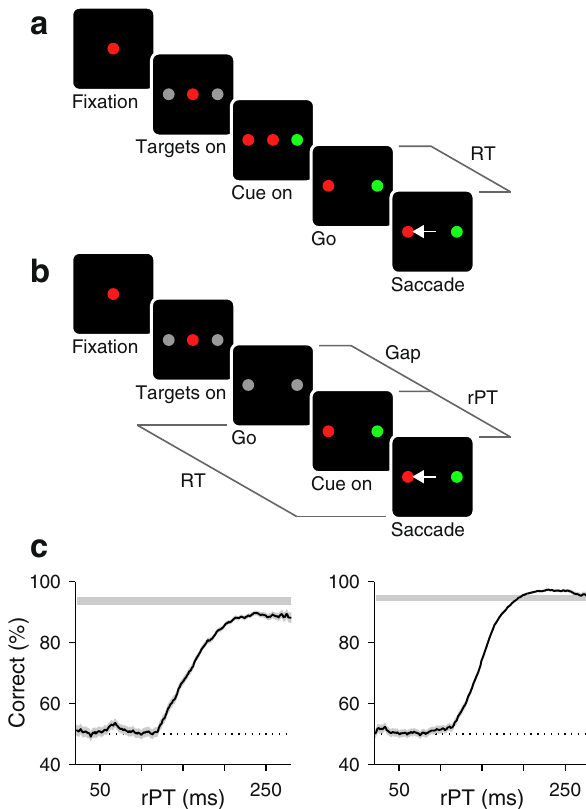
Fig. 5 | Urgent and non-urgent color-discrimination tasks. Subjects had to look to the peripheral target that matched the color of the fi xation point. a Easy, non- urgenttask.Thecolorstimuliare presented fi rst(Cue on),and after500 – 1000ms, thegosignal( fi xationpointoffset;Go)isgiven. b Urgenttask.Thegosignalisgiven fi rst, before the cue is revealed. All time parameters and intervals are as in the CRDM task (Fig. 1c). c Tachometric curves based on all the recording sessions during which the urgent color-discrimination task was performed by monkeys C (left,7330trials)andT(right,10,745trials).Eachpointincludestrialswithina51ms rPT bin. Traces show percentage of correct choices across trials in each bin, and shaded error bands indicate±1 SE. Gray horizontal strips indicate performance in thenon-urgenttask(95%con fi denceinterval).SourcedataareprovidedasaSource Data fi